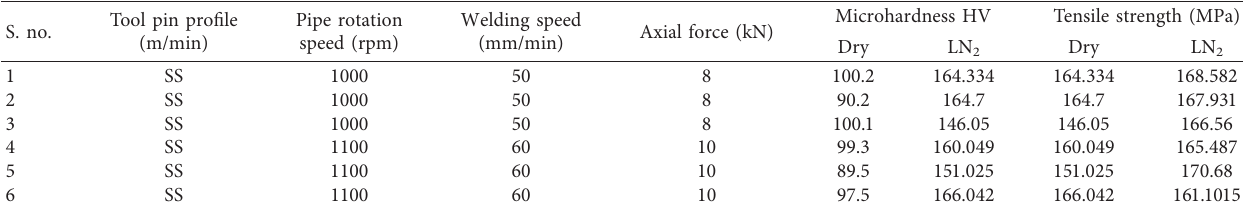
27 ) for dry and cryogenic friction stir welding of AA 7075 aluminium alloy.